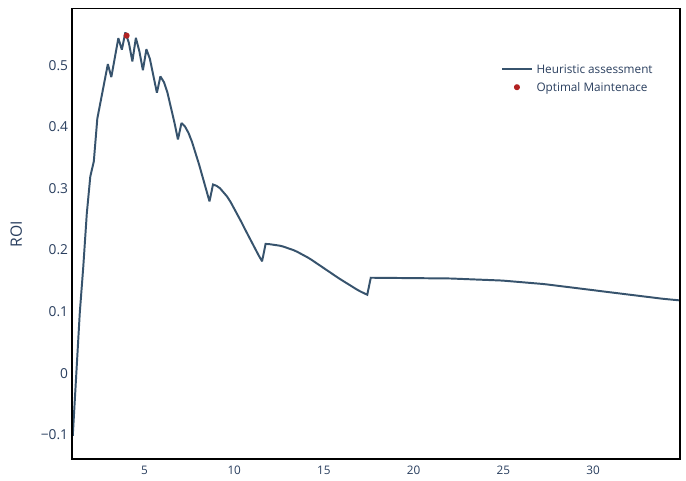
Figure 18. ROI for TR_1 considering different maintenance